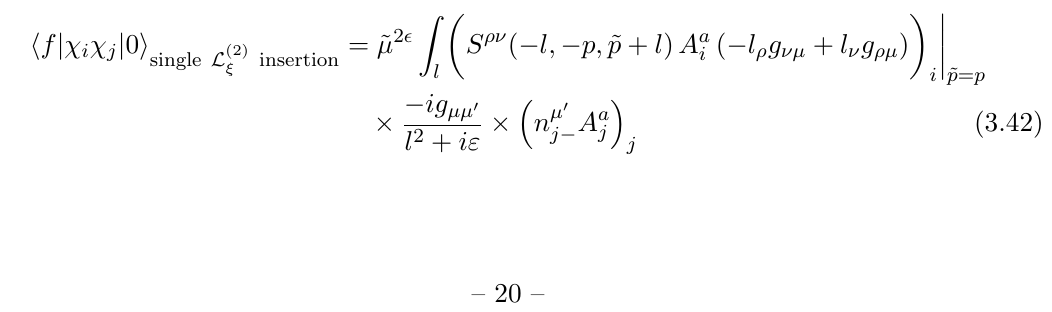
(2) (2) or . The relevant diagrams are obtained by YM (cid:24) L L